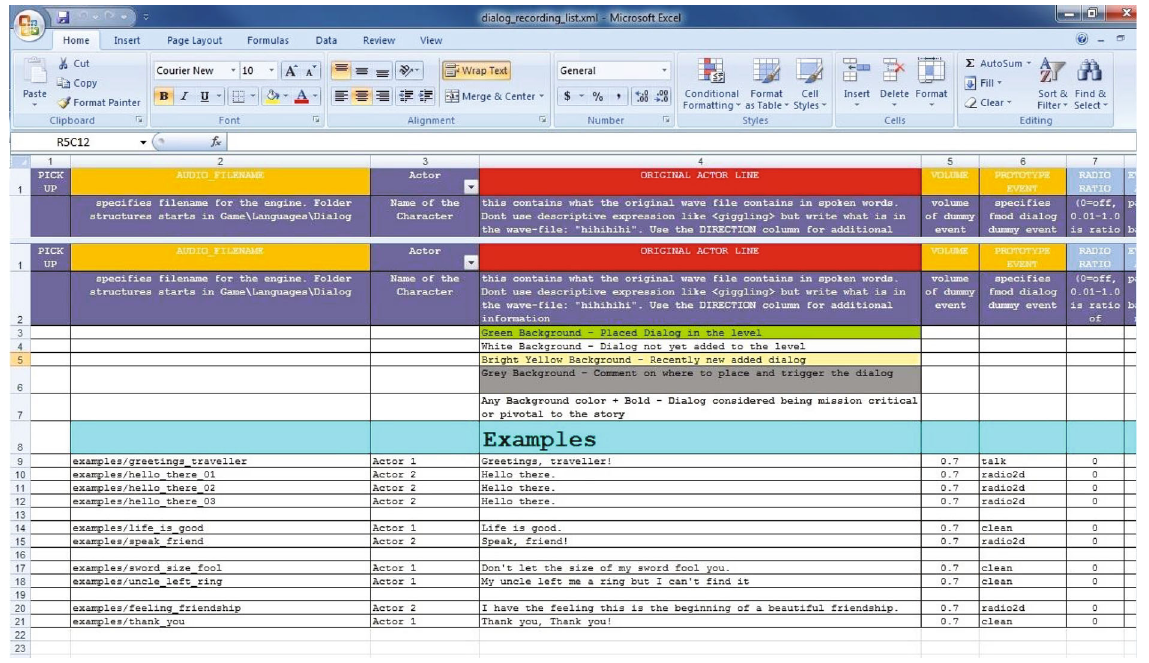
Figure 5: Screenshot of the Dialog System/Localization Manager section of CryEngine o ffi cial documentation